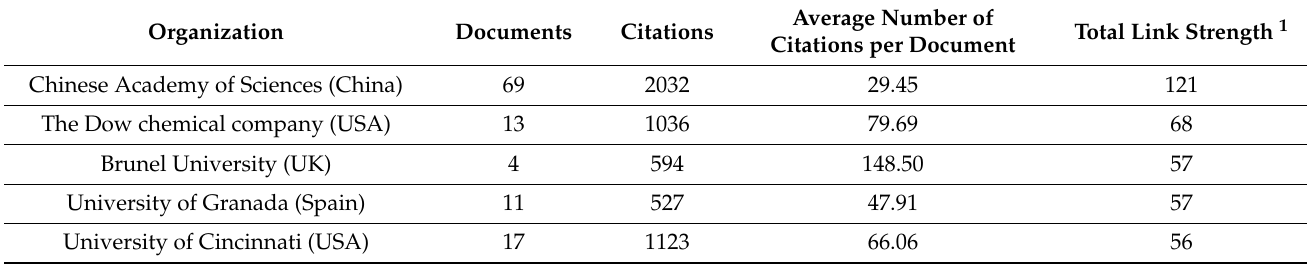
Table 2. The number of documents and citations of top 10 organizations (ranked according to their link